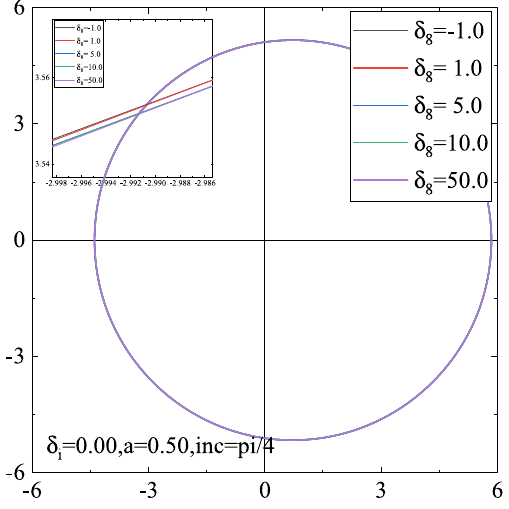
Fig. 8 The shadow of the black hole for the different values of param- eter δ 8 in the KRZ